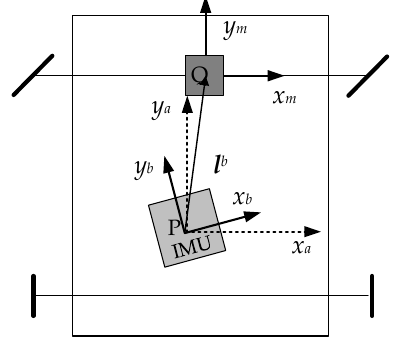
Figure 1. The relationship among a-frame, b-frame and m-frame. The IMU locate at the centroid of vehicle, the point P, and the odometer at the center of the front axle, the point Q. e-frame: It is a frame fixed to the Earth and the origin is at its center; the z e axis goes along Earth polar axis pointing to the North Pole; the x e axis points to the intersection of the prime meridian